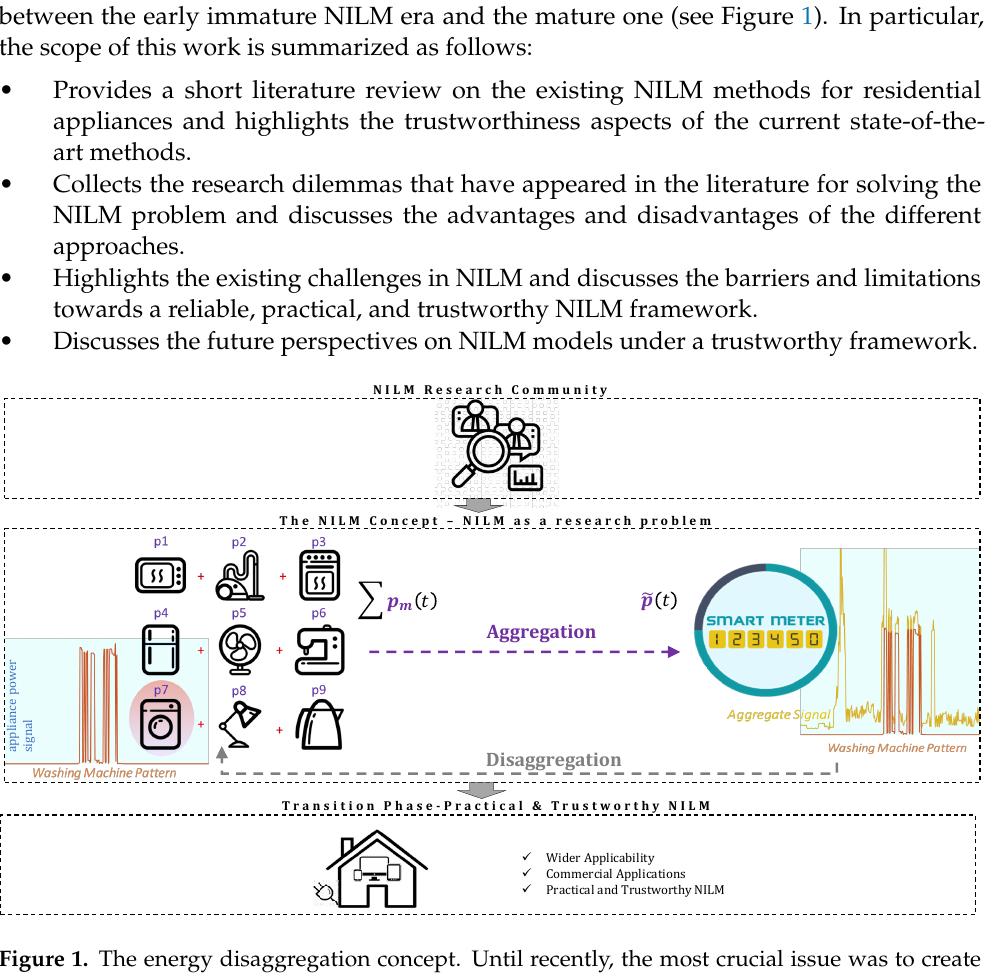
Figure 1. The energy disaggregation concept. Until recently, the most crucial issue was to create NILM algorithms with good performance. NILM belongs to the category of inverse problems, and formulating this mathematical problem and adapting it using machine learning models were quite challenging (early immature NILM era). Currently, given that the state-of-the-art algorithms achieve good performance, we come across the transition phase where the research interest is concentrated on practical and trustworthy NILM